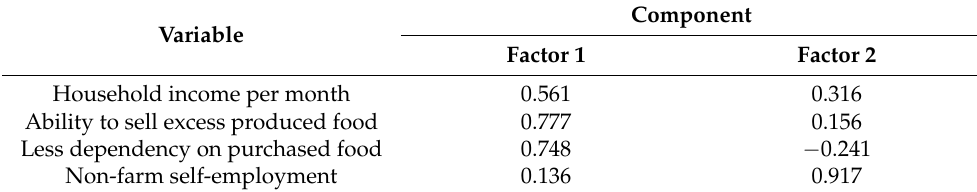
Table 5. Factor loadings on HEC.